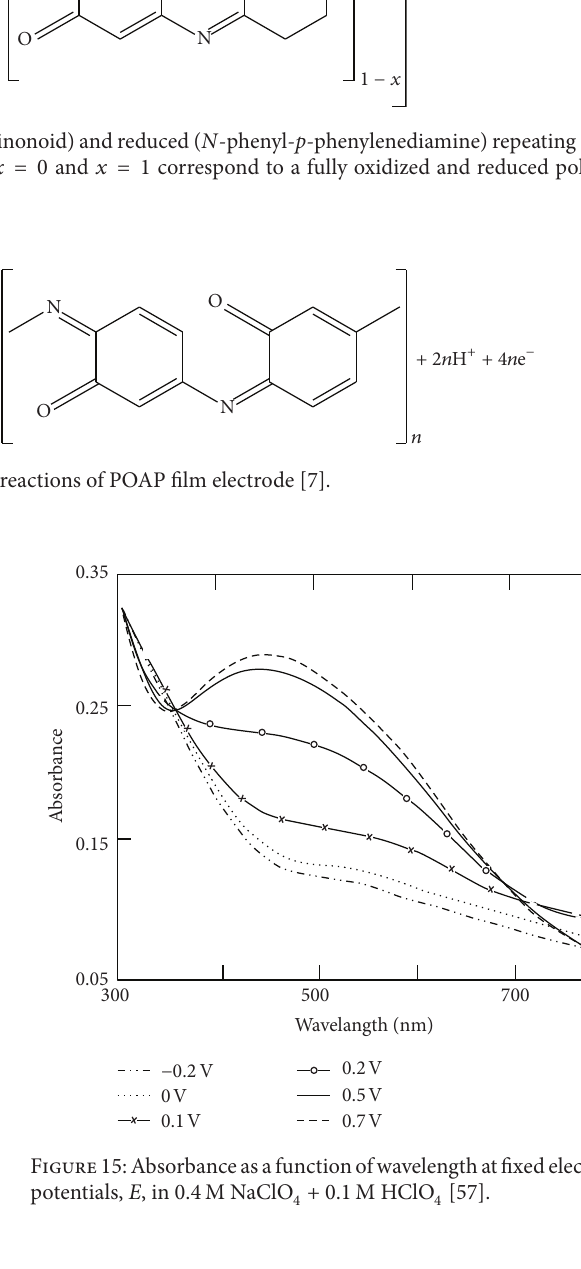
and correspond to a fully oxidized and reduced polymer 𝑥𝑥 𝑥 𝑥 𝑥𝑥 𝑥 𝑥